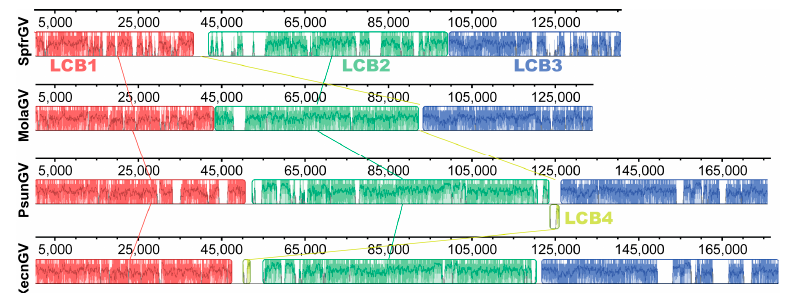
Figure 5. Genome comparison and gene content analyses of MolaGV and its related species. MolaGV sinteny is compared to three betabaculovirus genomes including SpfrGV, PsunGV, and XecnGV. Four Locally Collinear Blocks (LCB) numbered from 1 to 4 were found. As MolaGV presented smaller blocks in relation to both XecnGV and PsunGV, gene acquisition much probably took place on them. The main gain probably happened to the LCB2 region (green block) whereas LCB4 (yellow) is totally lacked by both the SpfrGV and MolaGV genome and seemed to undergo an inversion when XecnGV and PsunGV genomes are